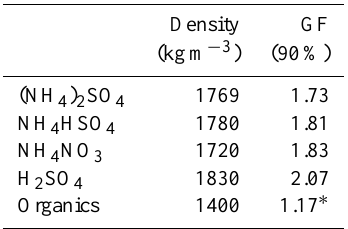
Table 2. HGF and bulk mass densities of all compounds used in the ZSR calculation (Gysel et al.,